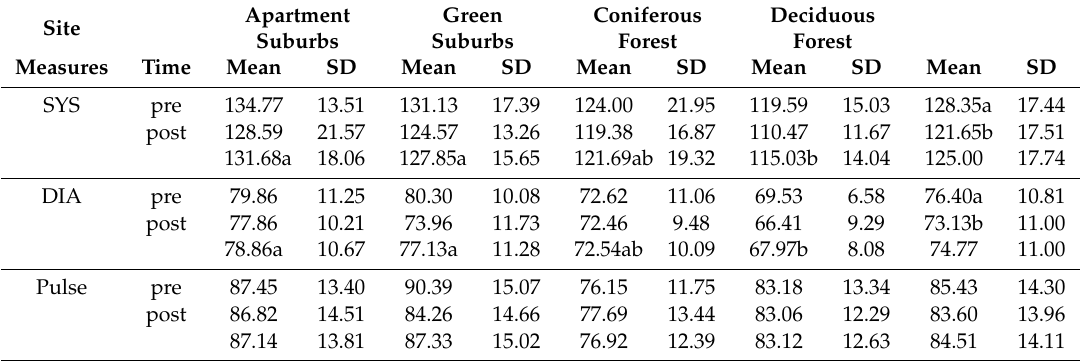
Table 2. Means and SD of physiological measures in four places during the experiment. Site Measures